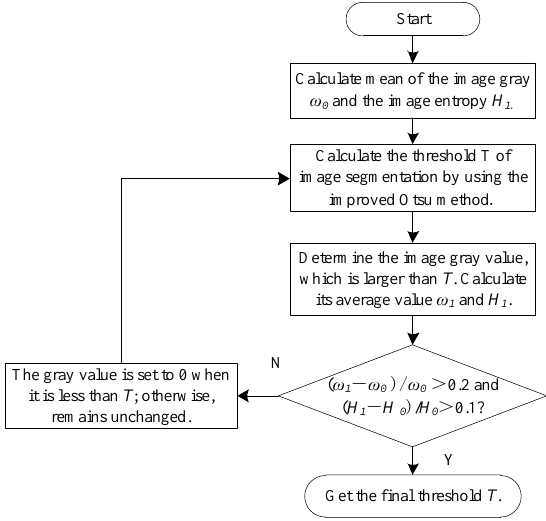
Figure 4. Flow chart of Otsu segmentation algorithm based on image entropy.